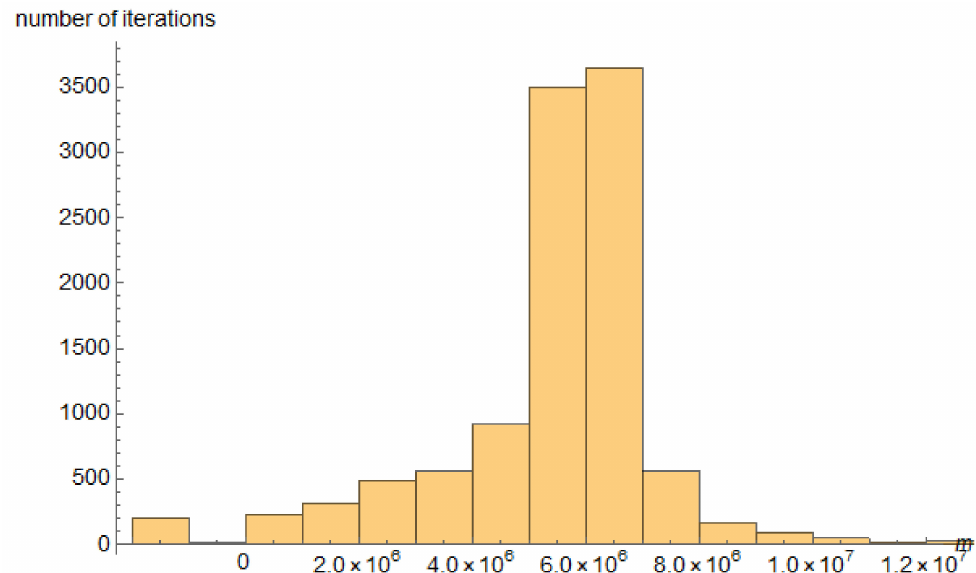
Figure 10. Histogram for market size ( m ) simulation results [own